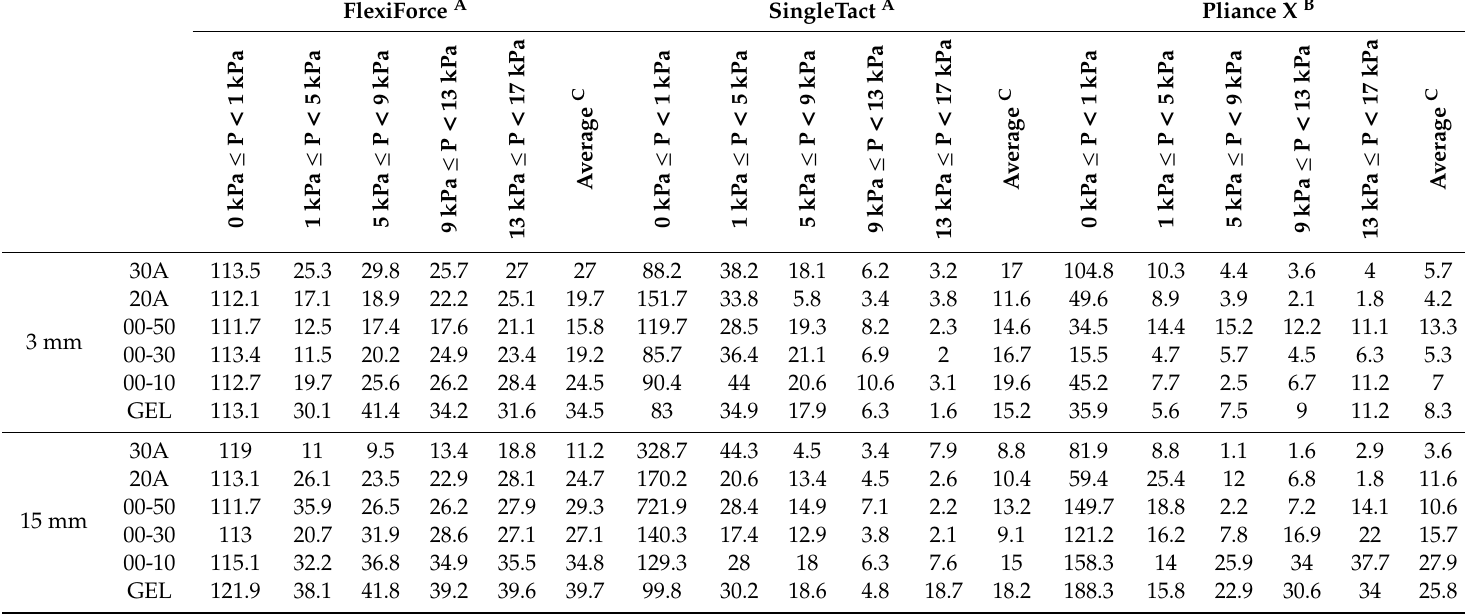
Table 5. Percentage error of di ff erent sensors when in contact with surfaces with di ff erent hardness with calibration on rigid surface. FlexiForce